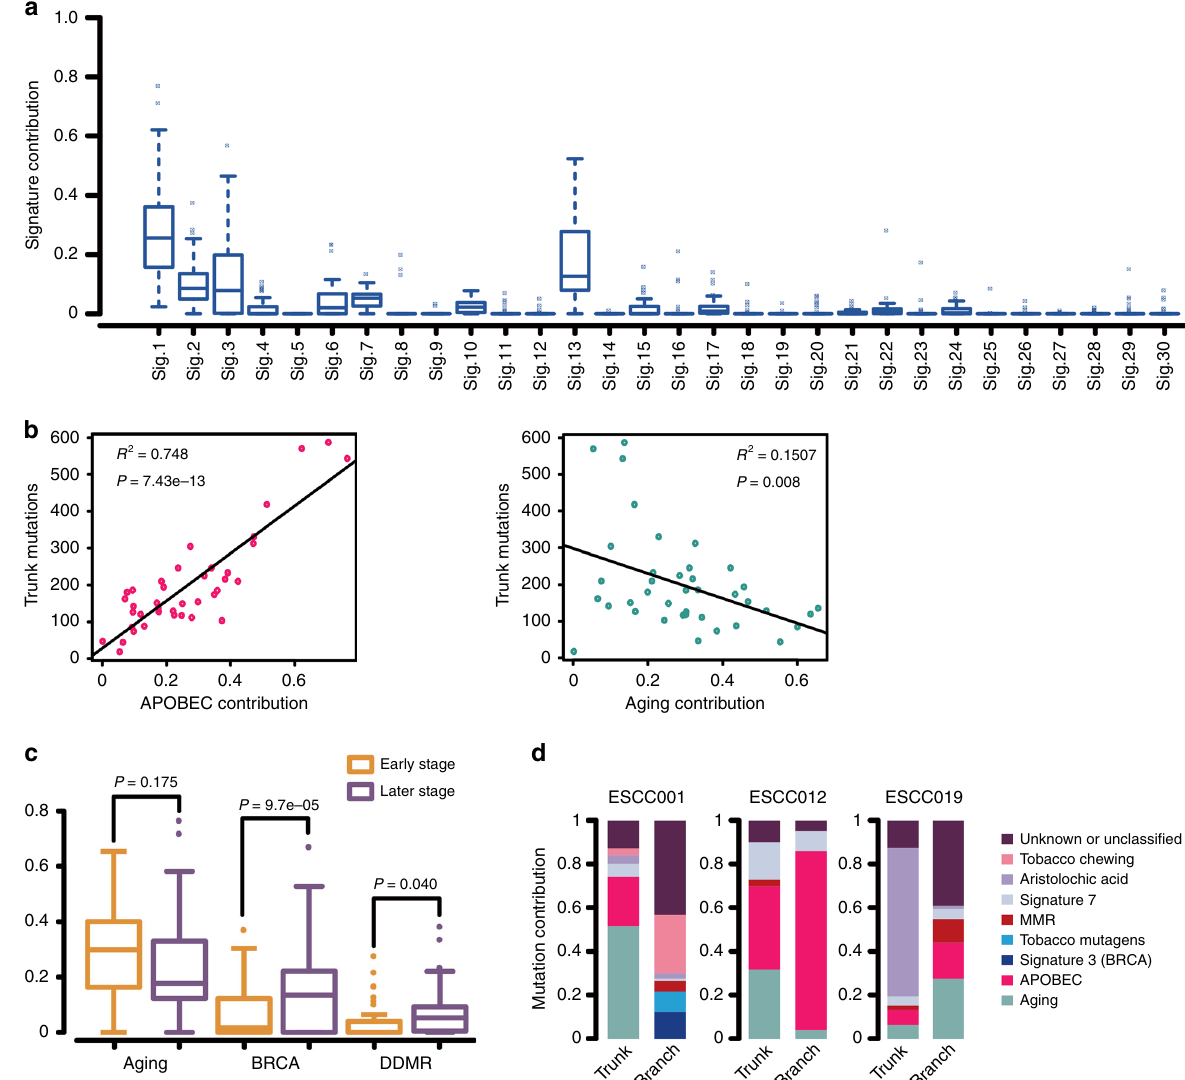
Fig. 3 Mutational processes in ESCCs. a The relative contribution of each mutational signature across 39 ESCCs. b Correlation between trunk mutations and APOBEC or aging signatures. F -statistics of the signi fi cant test based on linear regression. c Box plots in the left show the contribution of aging, BRCA, and DDMR signatures with tumor progression. Brown: early stage; Purple: later stage. d Relative contribution of mutational signatures changed between early and later stages in ESCC001, ESCC012, and ESCC019. Eight signatures were found to be important in ESCC, which included signatures associated with tobacco chewing, aristolochic acid, signature 7, MMR, tobacco mutagens, signature 3 (BRCA), APOBEC, and aging. “ Unknown or Unclassi fi ed ”